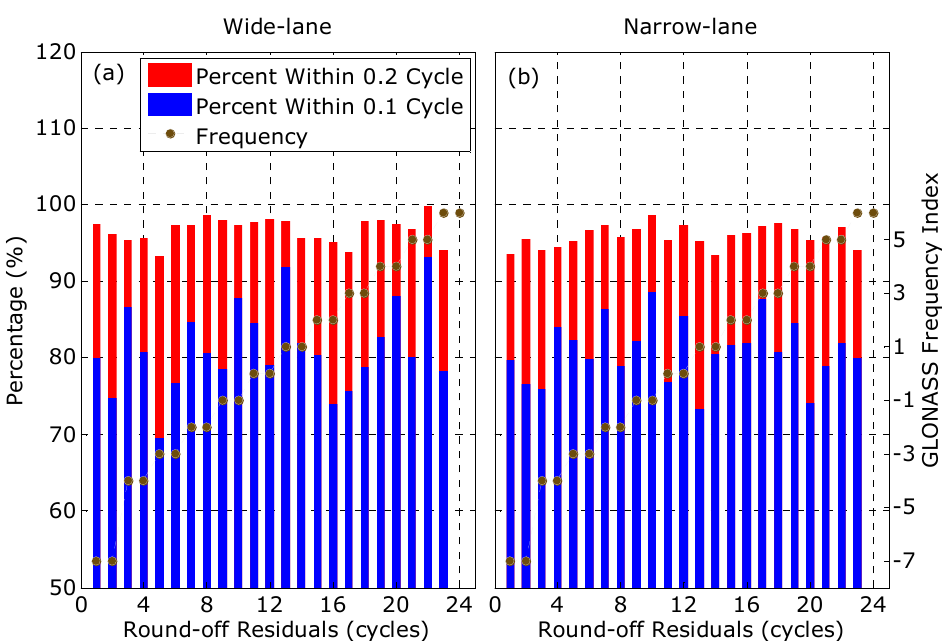
Figure 6. Percentages within 0.1 and 0.2 cycles for the a posteriori residuals in GLONASS wide- and narrow-lane SDBR ambiguities fixing when using the proposed method. ( a ) It shows the corresponding fixing percentages for the wide-lane ambiguities. ( b ) It shows the corresponding fixing percentages for the narrow-lane ambiguities.